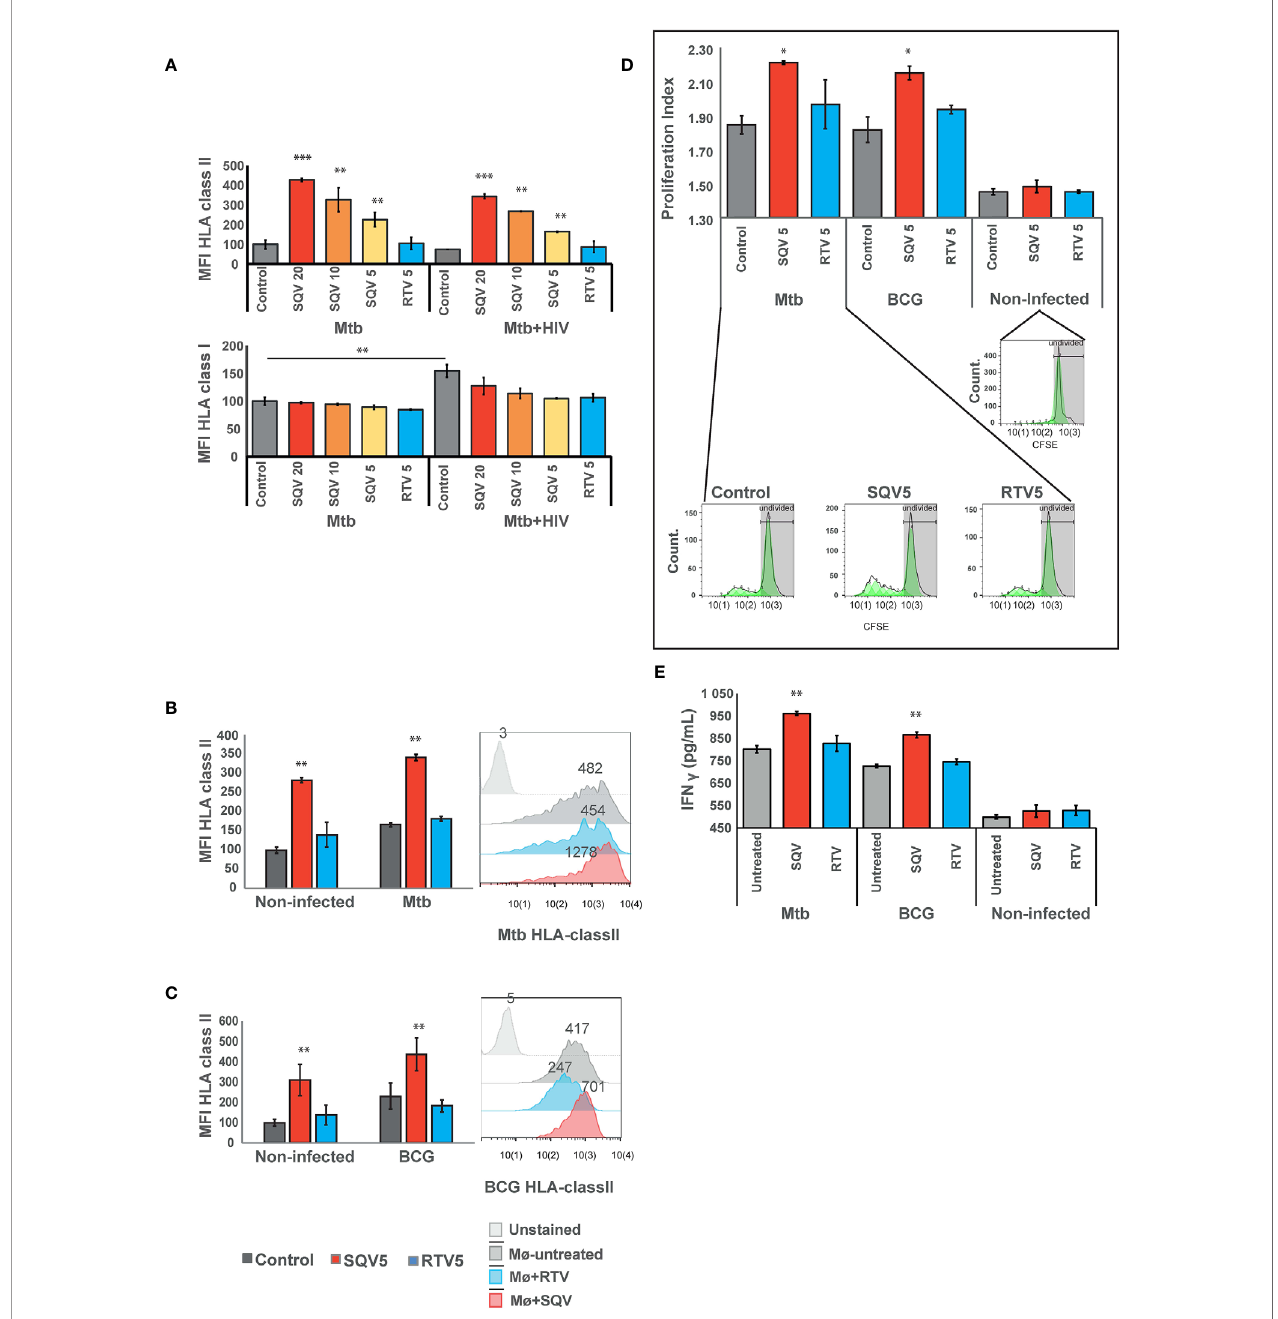
FIGURE 3 | SQV results in increased expression of HLA class II antigen presentation machinery (A) Surface expression of human leukocyte antigen (HLA)-class II or class I on Mø infected with Mtb or co-infected with HIV. (B) Surface expression of human leukocyte antigen (HLA)-class II on Mø infected with Mtb or (C) BCG compared to non-infected Mø. HLAs were measured by fl ow cytometry after 24 h of infection. Values in bar plots represent the average of median fl uorescence intensity measured on three biological replicates from one representative experiment performed in triplicate relative to control. Error bars depict standard deviation (** P < 0.001, relatively to control). Raw values from one representative replicate are presented in the fl uorescence intensity histograms. (D) CD4 + T-cell proliferation after 5 days of coculture with Mtb or BCG-infected Mø. Following 24 h of the infection, CFSE stained CD4 + T-cells were added to the infected Mø culture. After 5 days of coculture, CD4 + T-cells CFSE fl uorescence was measured by fl ow cytometry. Values in bar plots represent the proliferation index (average number of divisions per cell) of CD4 + T-cell (* P < 0.01, relatively to control). Histograms from one representative replicate of the different treatments infected with Mtb are presented in the bottom. The green areas represent the CD4 + T-cell populations after each division as modeled by the software. (E) IFN- g was quanti fi ed in the supernatant after 5 days of cocultures of Mø with CD4 + T-lymphocytes by ELISA. Values depict mean concentration of three biological replicates from one representative experiment performed in duplicate. Error bars depict the standard deviation (** P < 0.01; *** P < 0.001, relatively to